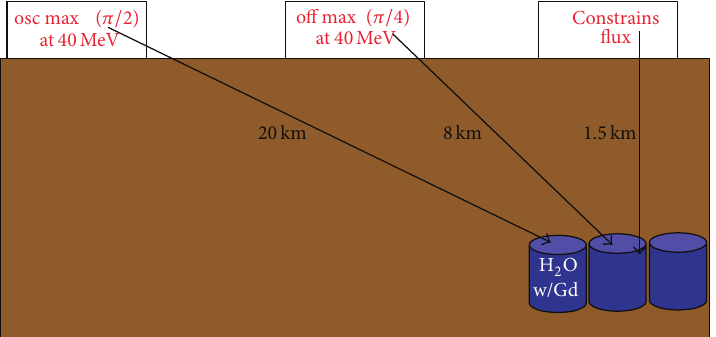
Figure 13: Schematic of the DAE 𝛿 ALUS experiment. Three neutrino source locations are used in conjunction with a large water Cherenkov or scintillator-based